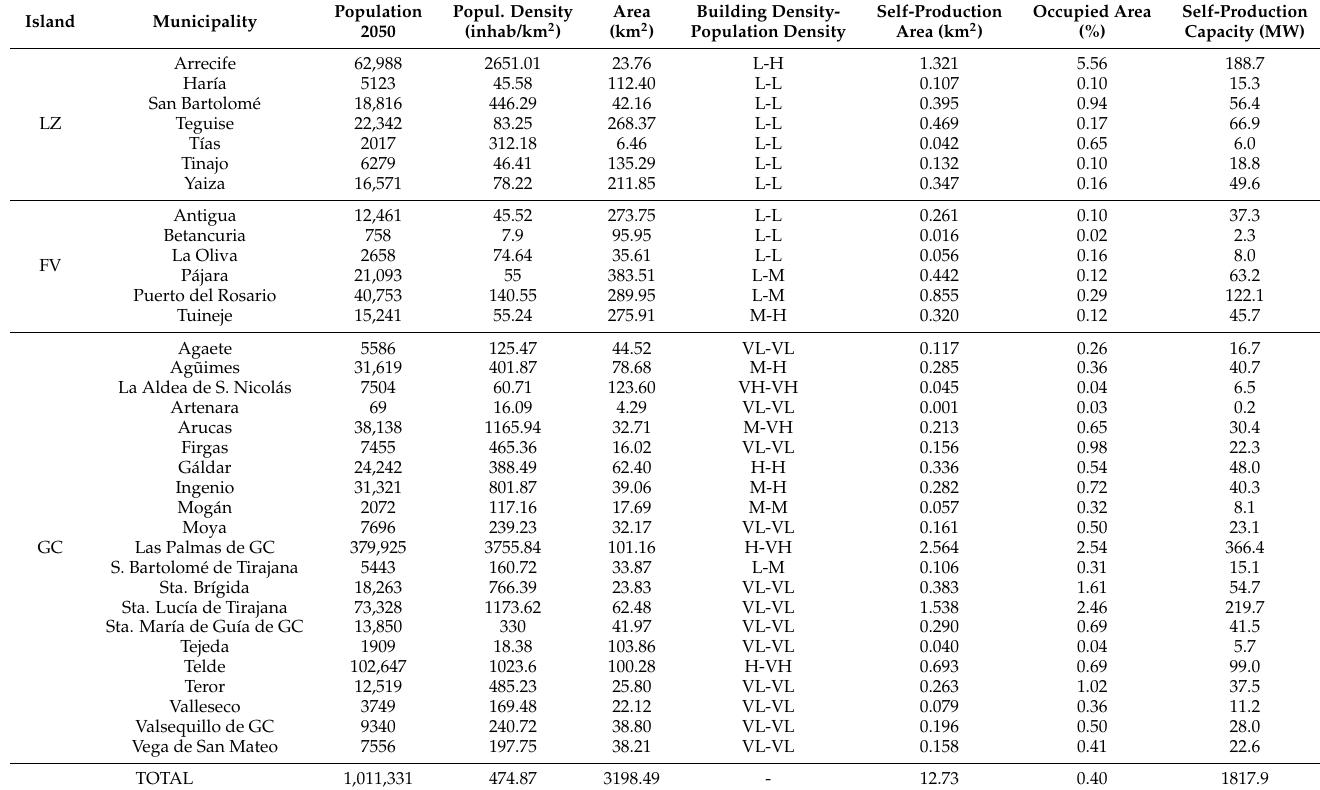
Table 8. Solar PV self-generation potential capacity